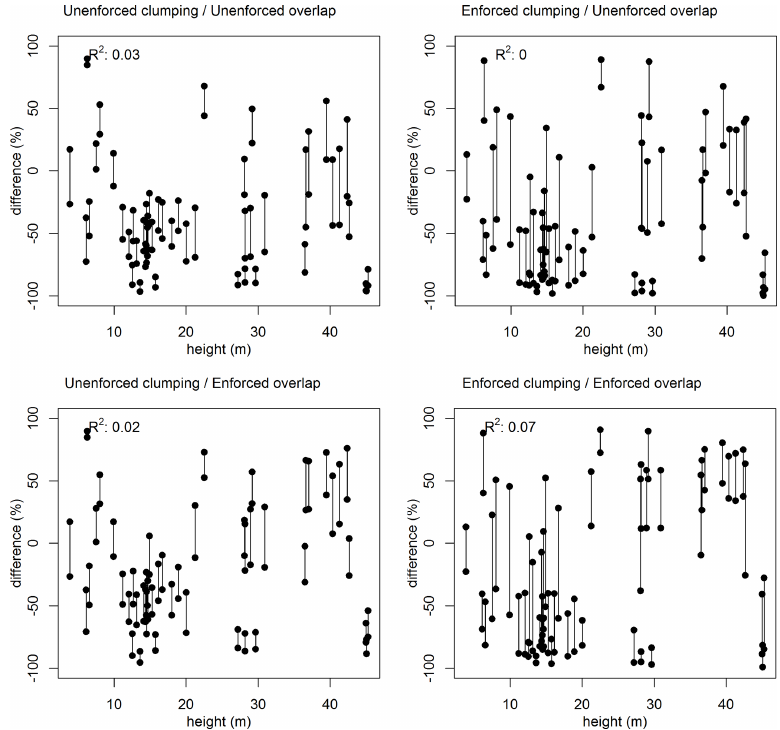
Figure A4. TROBIT plot upper-stratum height versus the difference between MODIS VCF and TROBIT percent tree cover for the four clumping and overlap scenarios. Upper and lower bars represent the uncertainty range’s 10th and 90th percentile, respectively, based on the convolution of MODIS VCF and TROBIT cover uncertainties from Fig.